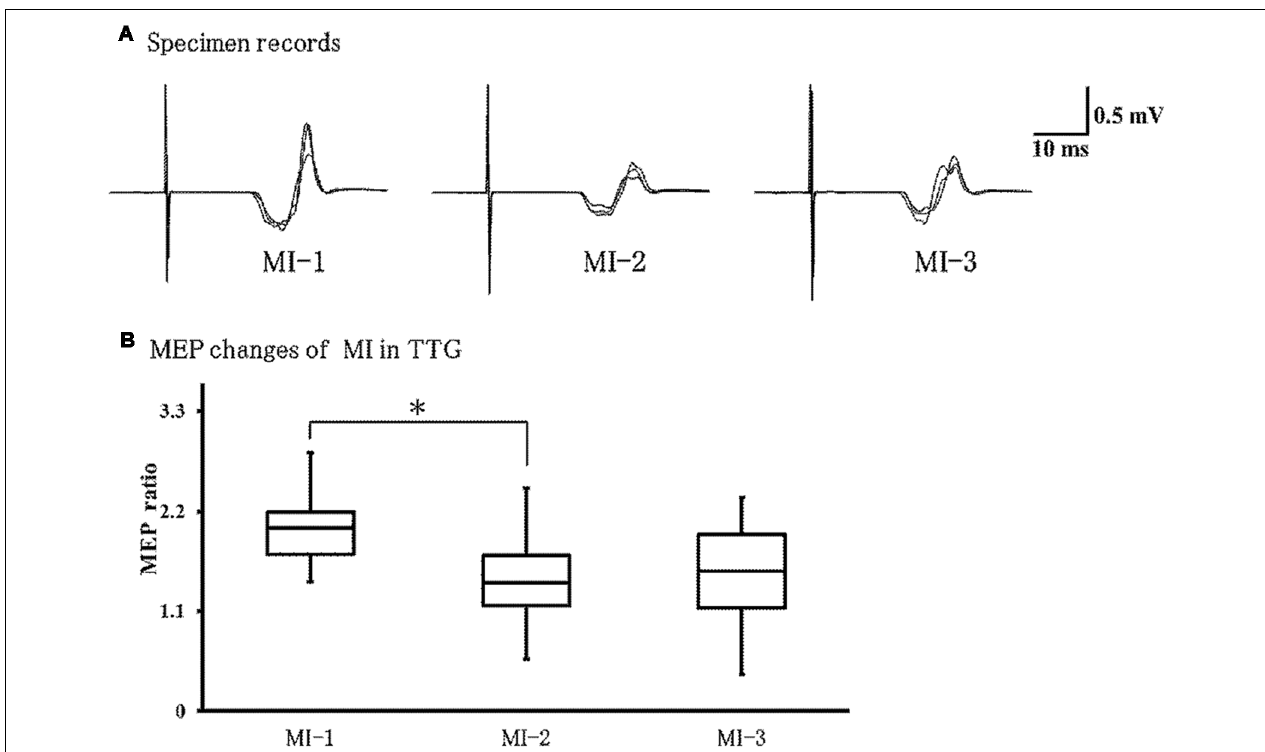
FIGURE 5 | Changes in motor evoked potentials (MEPs) during left-hand MI in the TTG. (A) Representative EMG recordings from the extensor carpi radius muscles from a single subject in the transfer training group, across three conditions. (B) Quantification of MEP ratio in the three conditions. MEP ratio was significantly lower at MI-2 than at MI-1 ( p = 0.037). In addition, there were no significant differences between other conditions. ∗ p <